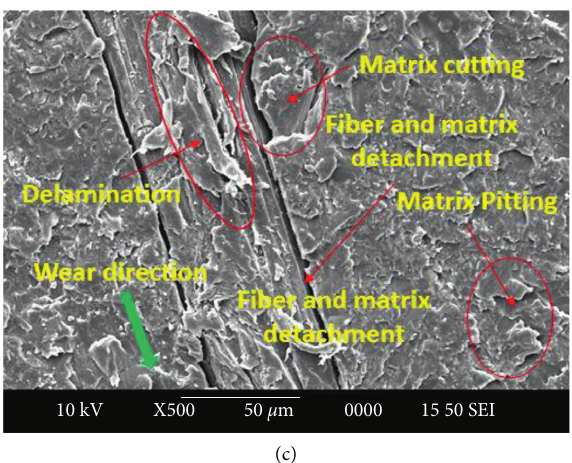
Figure 12: SEM images of worn surfaces using a variety of input parameters such as load, sliding velocity, and sliding distance. (a) 10N, 2 m/ s, and 500m. (b) 10N, 4m/s, and 1500m. (c) 30N, 4m/s, and